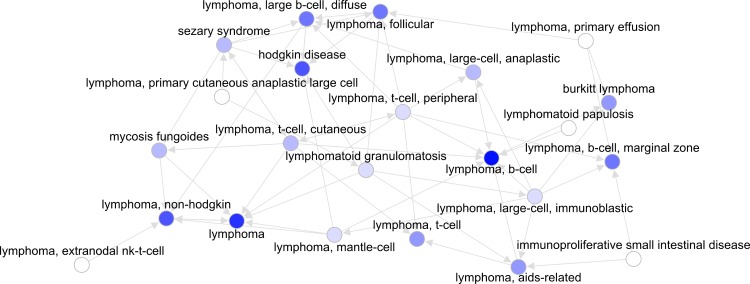
Lymphoma subnetwork based on the Literature dataset.Node colors are based on in-degree.